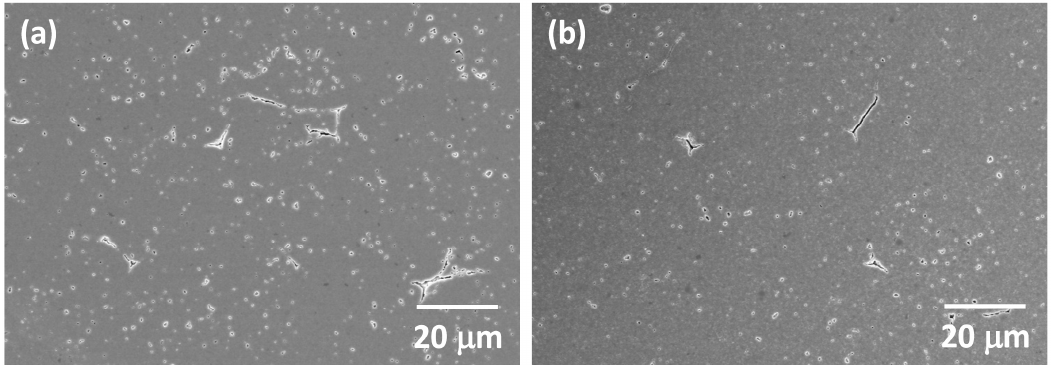
Figure 17. SEM micrographs of ( a ) a two-step sintered sample (T1 = 1400 °C, T2 = 1350 °C, t2 = 20 h) and ( b ) a conventionally sintered sample, both prepared from as-received powder.